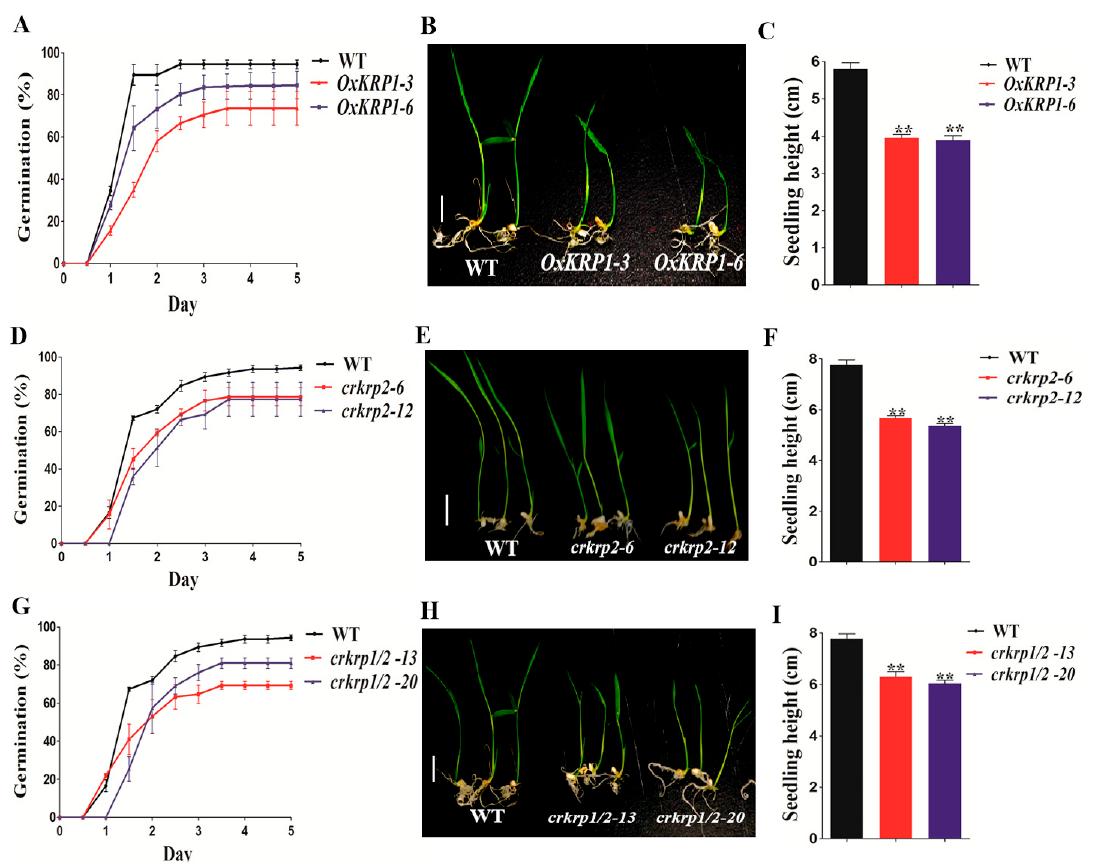
Figure 3. Seed germination characteristics of OxKRP1 , crkrp2 , and crkrp1 / 2 mutants. ( A ) Germination time courses of the WT and OxKRP1 on half-strength MS medium, respectively; ( B ) germination phenotypes of the WT and OxKRP1 growth on half-strength MS medium for 5 days, respectively; ( C ) seedling heights of the WT and OxKRP1 growth on half-strength MS medium for 5 days, respectively; ( D ) germination time courses of the WT and crkrp2 mutants on half-strength MS medium, respectively; ( E ) germination phenotypes of the WT and crkrp2 mutants growth on half-strength MS medium for 5 days, respectively; ( F ) seedling heights of the WT and crkrp2 mutants growth on half-strength MS medium for 5 days, respectively; ( G ) germination time courses of the WT and crkrp1 / 2 mutants on half-strength MS medium, respectively; ( H ) germination phenotypes of the WT and crkrp1 / 2 mutants growth on half-strength MS medium for 5 days, respectively; ( I ) seedling heights of the WT and crkrp1 / 2 mutants growth on half-strength MS medium for 5 days, respectively. Photographs were taken on day 5, Bar = 1 cm in ( B , E , H ). Error bars indicate SD with triple biological replicates ( n = 3, each replicates containing 50 seeds) in ( A , D , G ). Error bars indicate SD with 50 biological replicates ( n = 50) in ( C , F , I ). Asterisks indicate the significant di ff erence between the WT and transgenic lines, as determined by Student’s t -test analysis: ** p < 0.01 in ( C , F , I ). WT: wild type, MS: Murashige and Skoog medium.